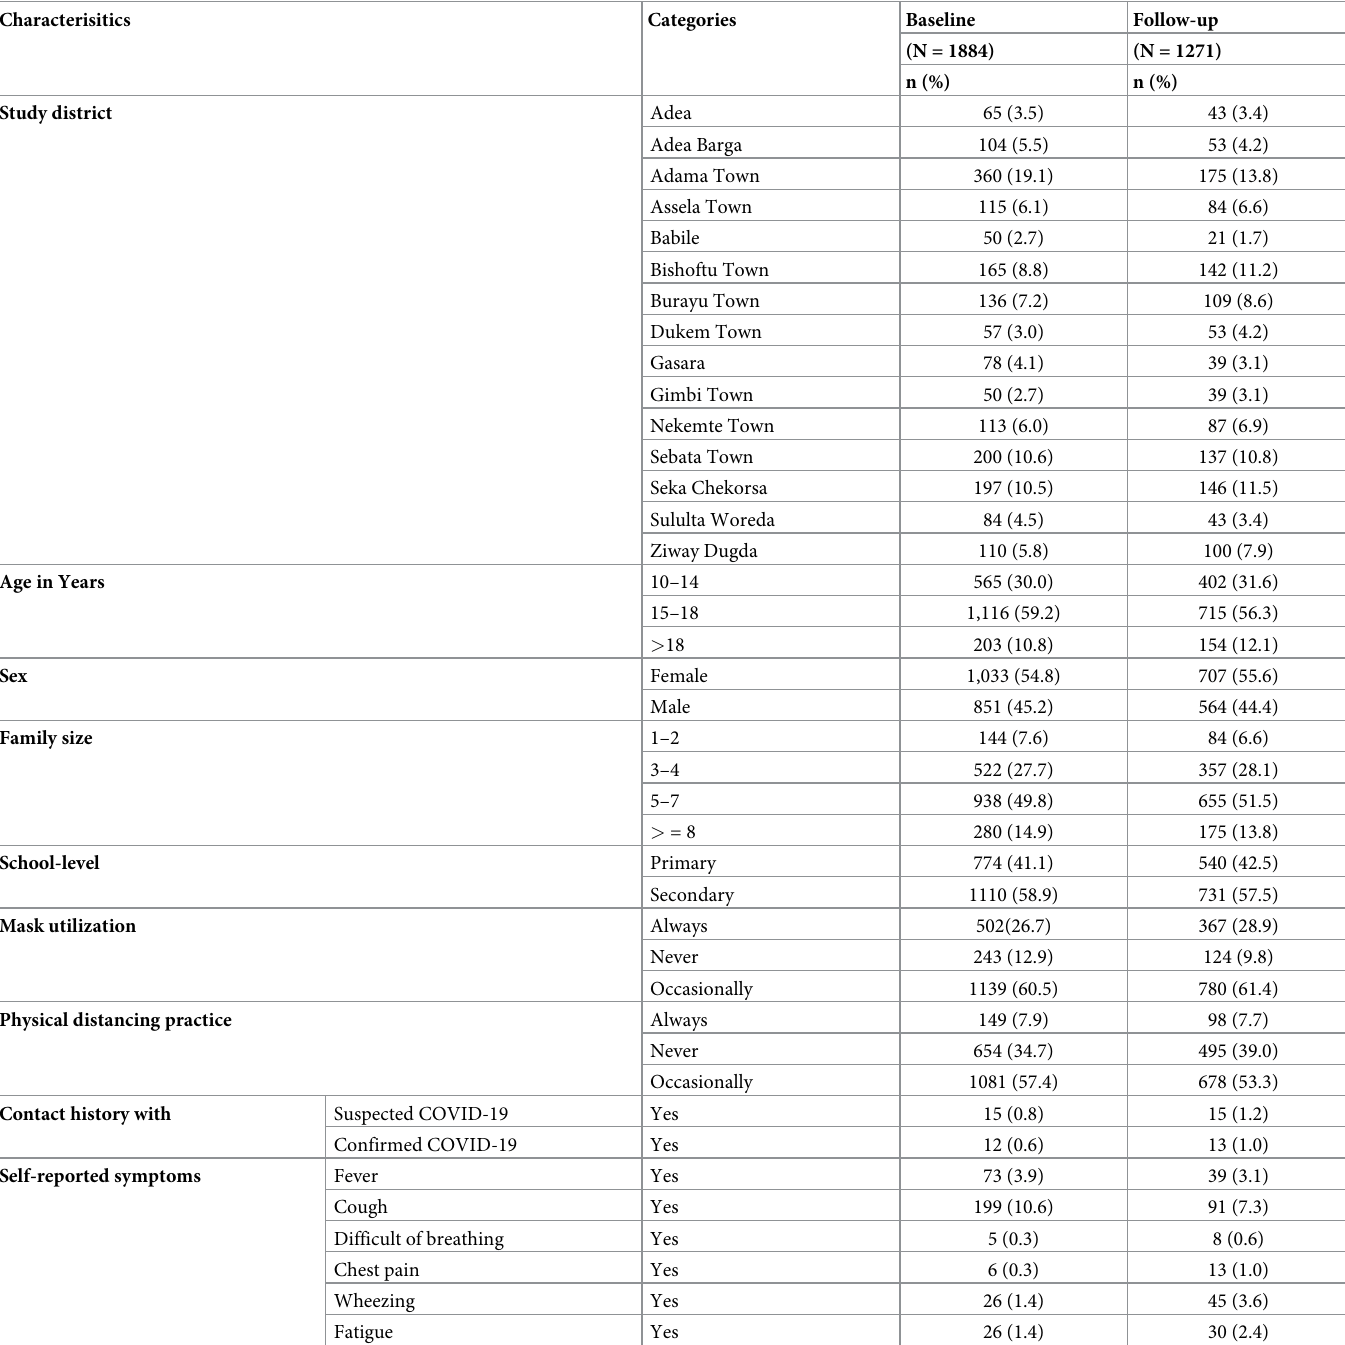
Table 1. Study district and participants’ socio-demographic characteristics by study rounds, base line (December, 2020) and follow up (April,